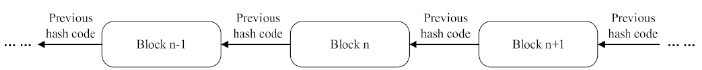
Figure 3. Blockchain hash connection